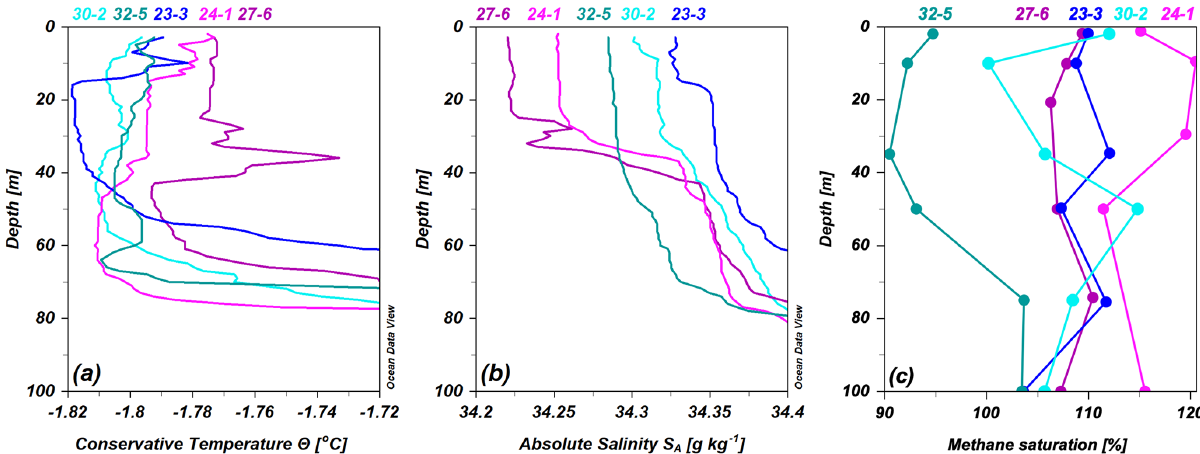
Figure 8. Profiles of (a) conservative temperature ( ◦ C), (b) absolute salinity (gkg − 1 ), and (c) methane saturation (%) for some of the sites with warmer and fresher waters in the topmost layers, indicating the onset of the seasonal ice melt to various degrees. The stations are indicated by the labels on top of each